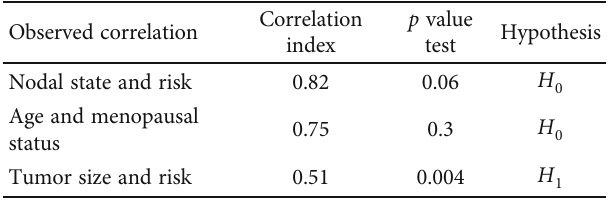
Table 8: Hospital correlation hypothesis tests.